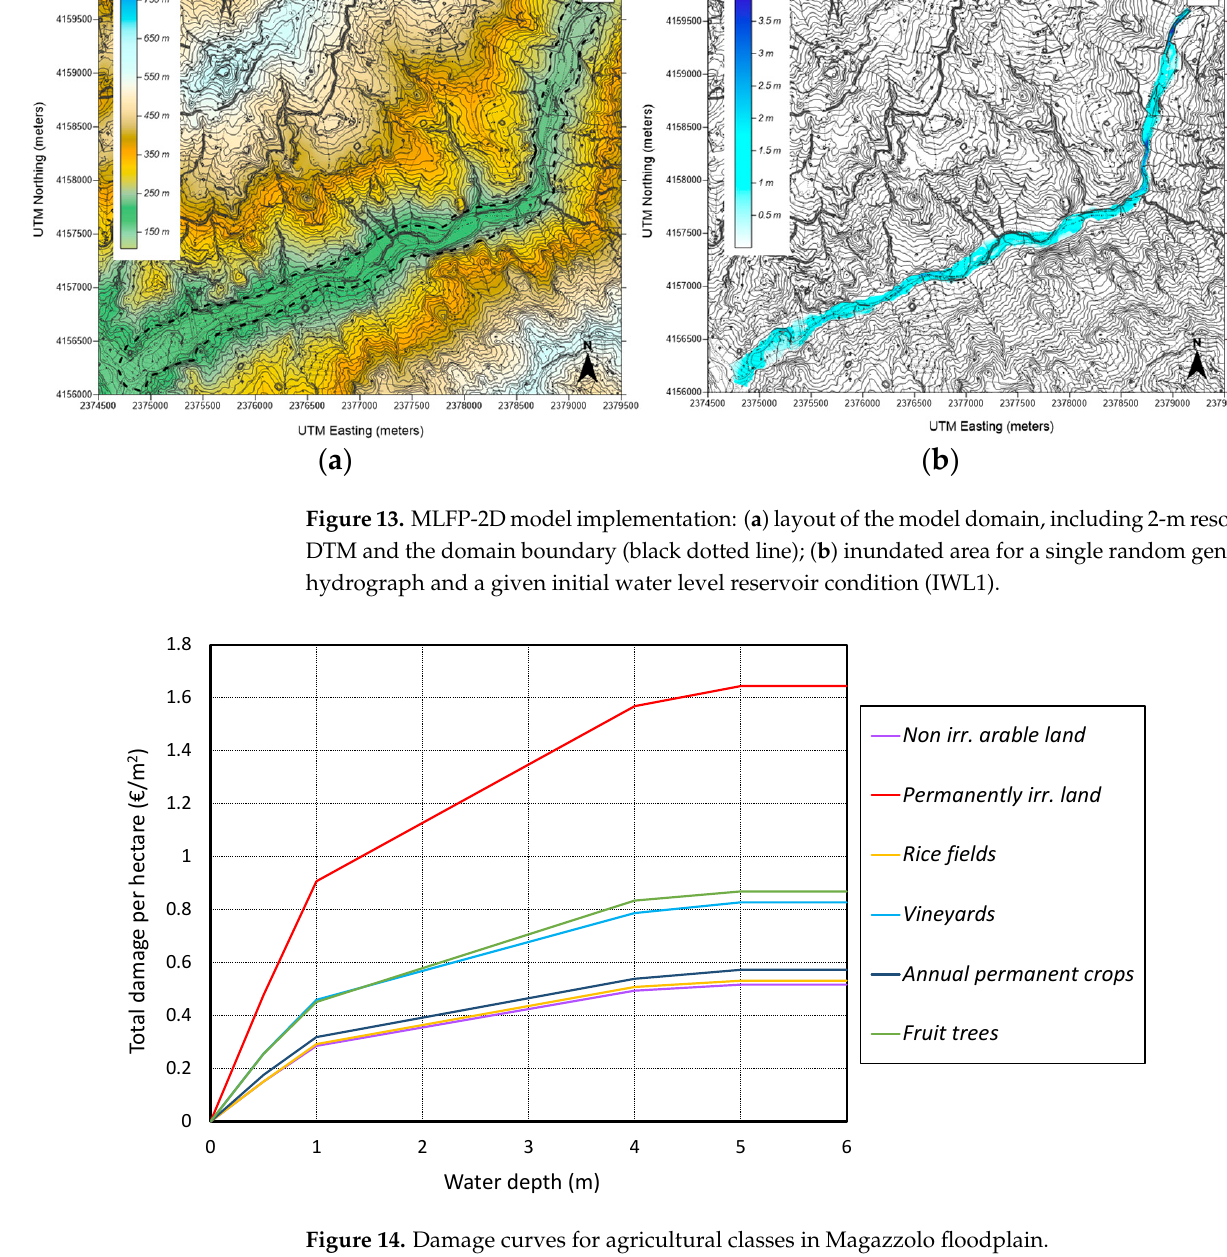
Figure 14. Damage curves for agricultural classes in Magazzolo floodplain.